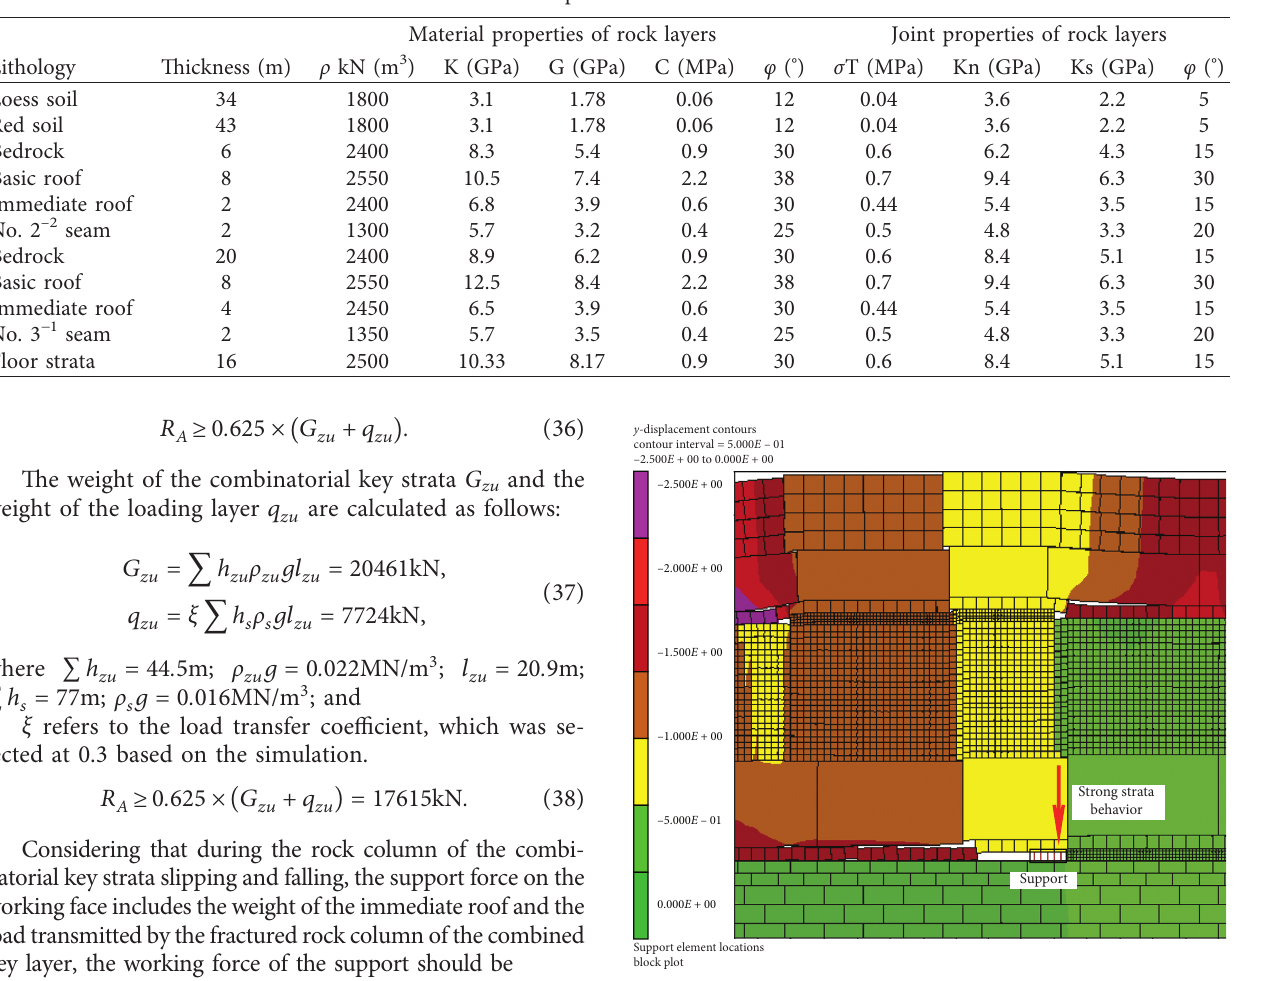
Figure 8: y -displacement contours under concentrated coal